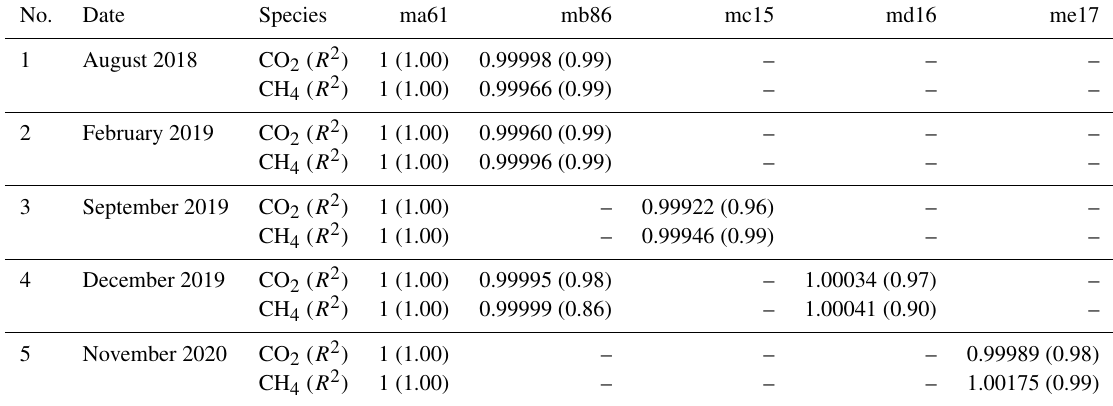
Table B1. Scaling factors of the side-by-side measurements with reference to our standard instrument ma61 for CO 2 and CH 4 . No.